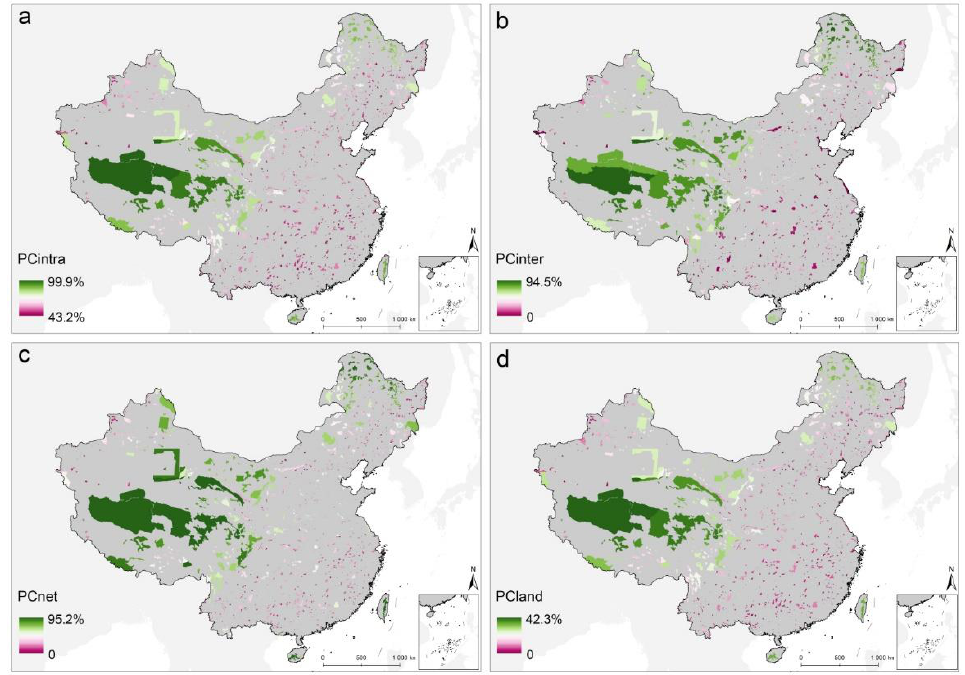
Figure 2. ( a ) Intra-patch connectivity of protected area (PA) patches in China based on PCintra indicator. ( b ) Inter-patch connectivity of PA patches in China based on PCinter indicator. ( c ) Network connectivity of PA patches in China based on PCnet indicator. ( d ) PA-landscape connectivity of PA patches in China based on PCland indicator. Table 1. Connectivity indicators of ecological zones’ PA network.